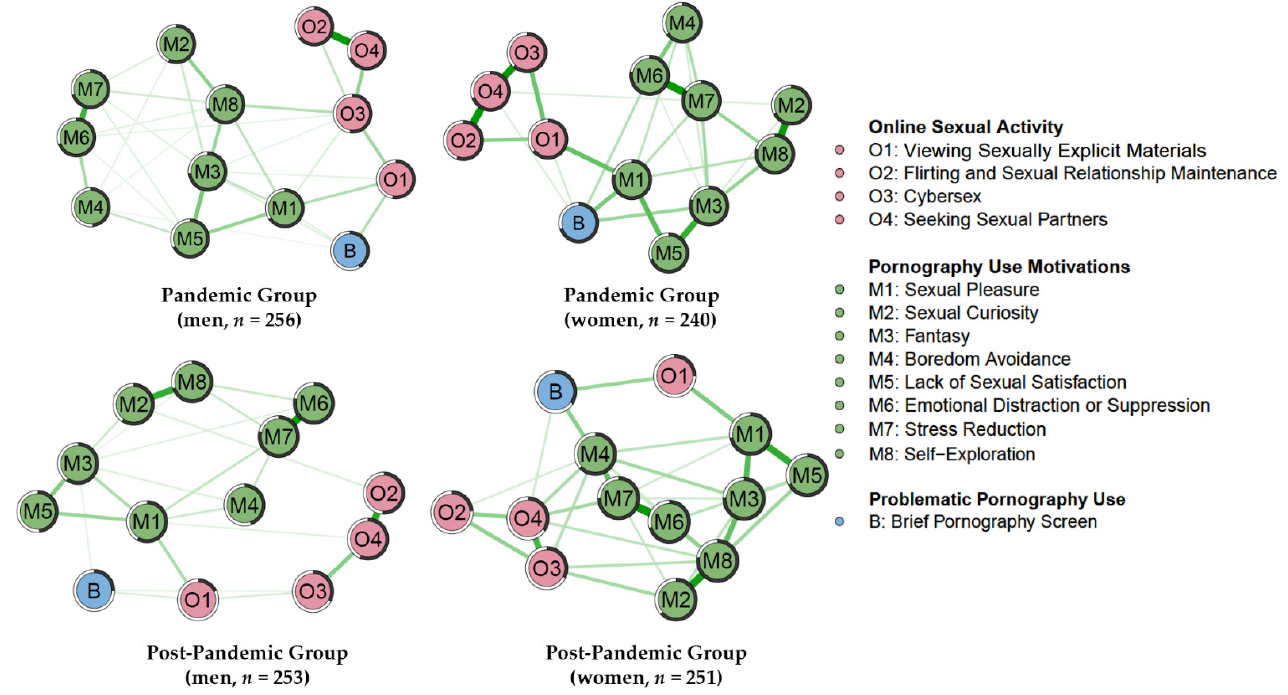
Figure A1. Network topology for PUM, OSA, and BPS by gender. Table A1. Explained variances ( R 2 ) for variables included in the networks.